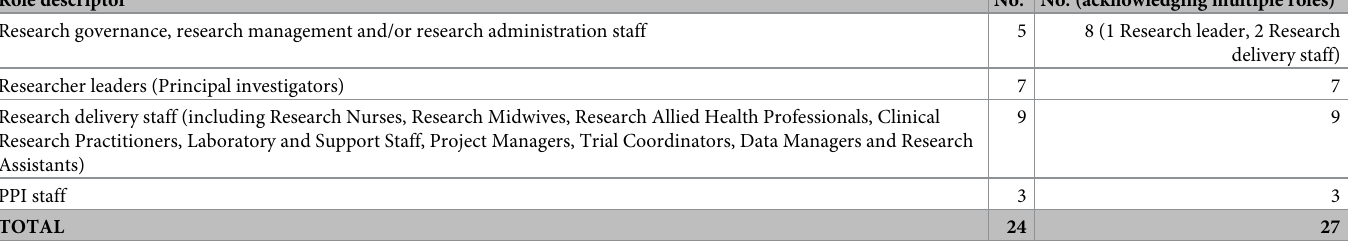
Table 2. Interview participants by role